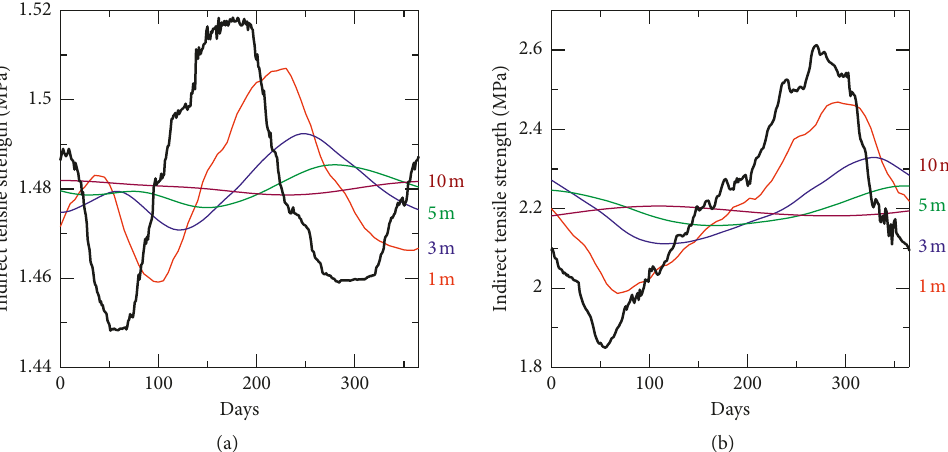
Figure 19: Simulation of annual variation. Time is from February 15. The thick black lines show the boundary condition at the bottom. (a) Underground. (b)